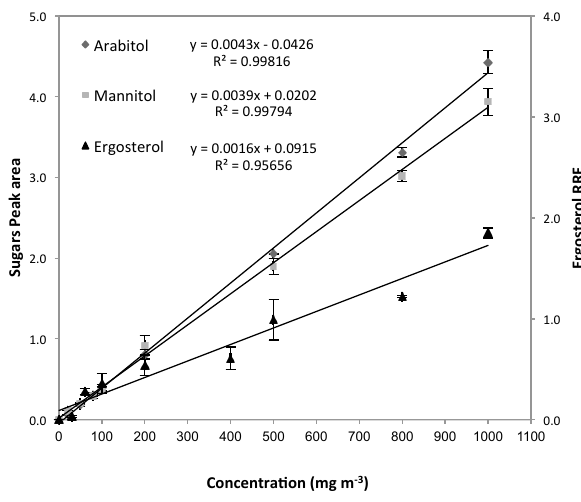
Fig. 2. Calibration curves for arabitol, mannitol and